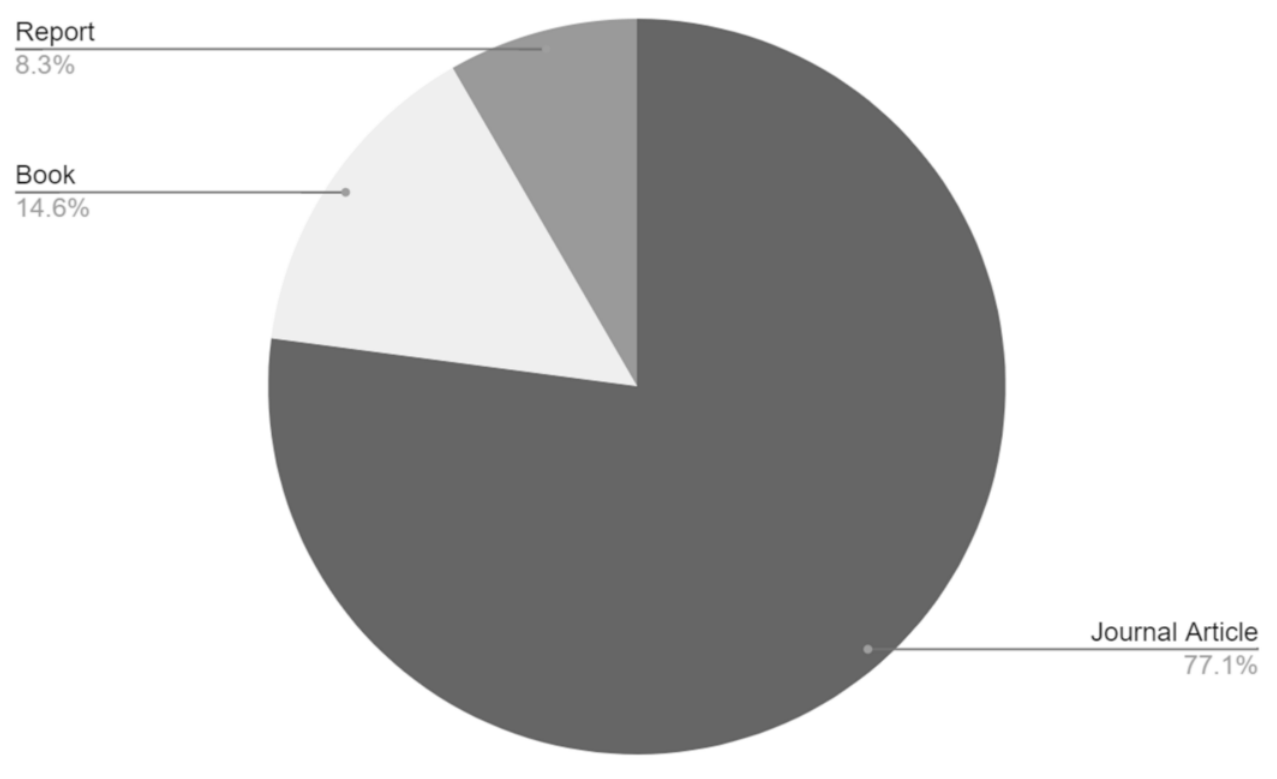
Figure 4. Reference type from which studies in the evidence map were